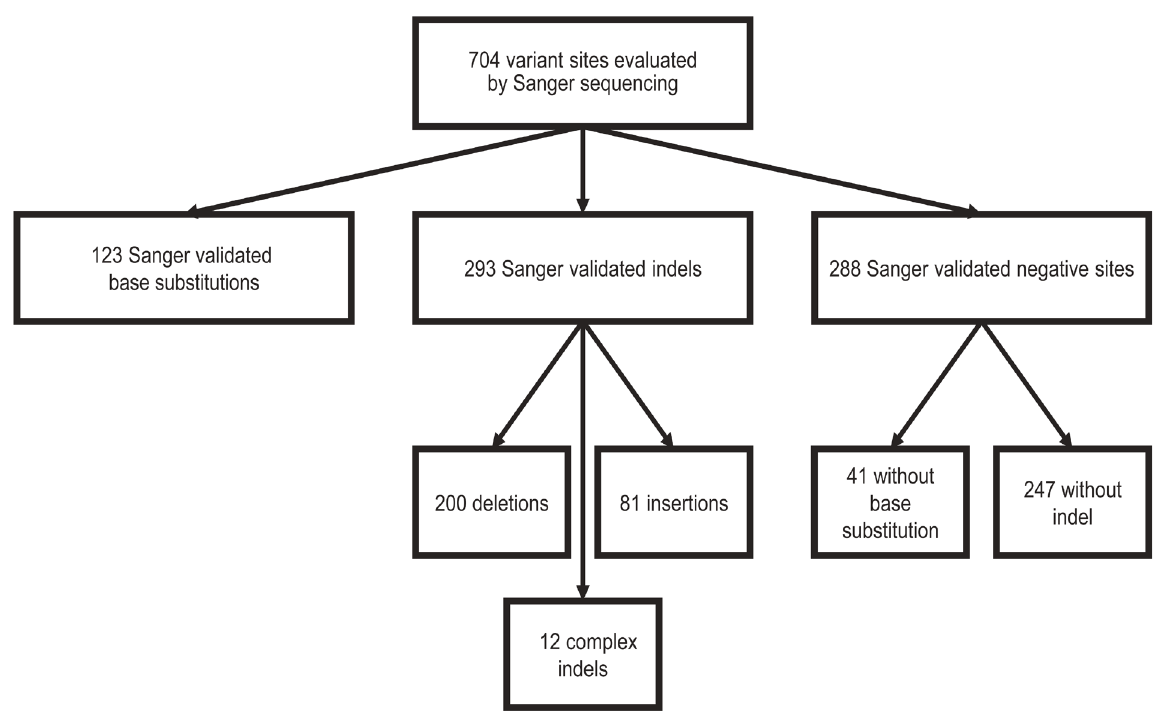
Figure 1. Description of variant sites evaluated by Sanger sequencing in the ICR142 NGS validation